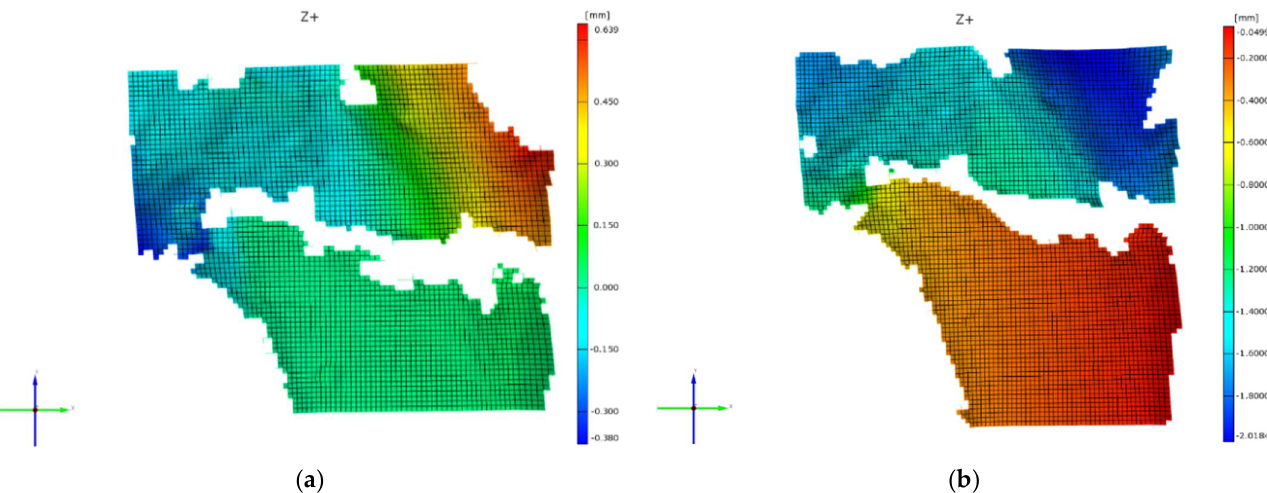
Figure 10. Values of the displacement in the Oy direction during Fujisawa point loading ( a ) and medial loading ( b ).